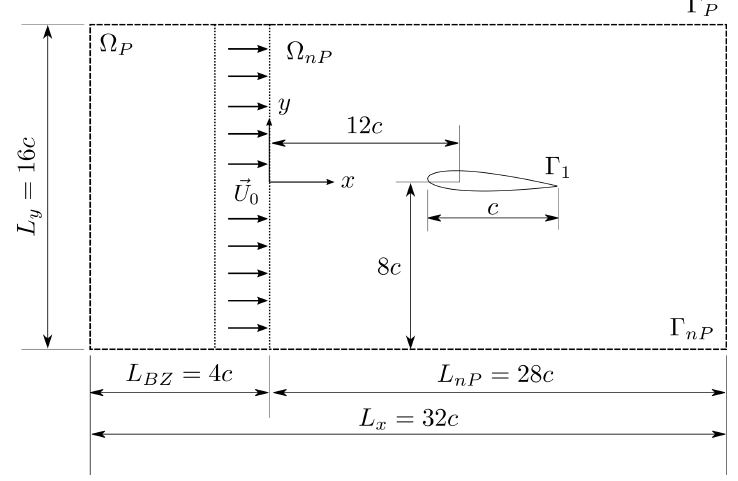
Figure 6. Calculation domain for the solution of flows over an